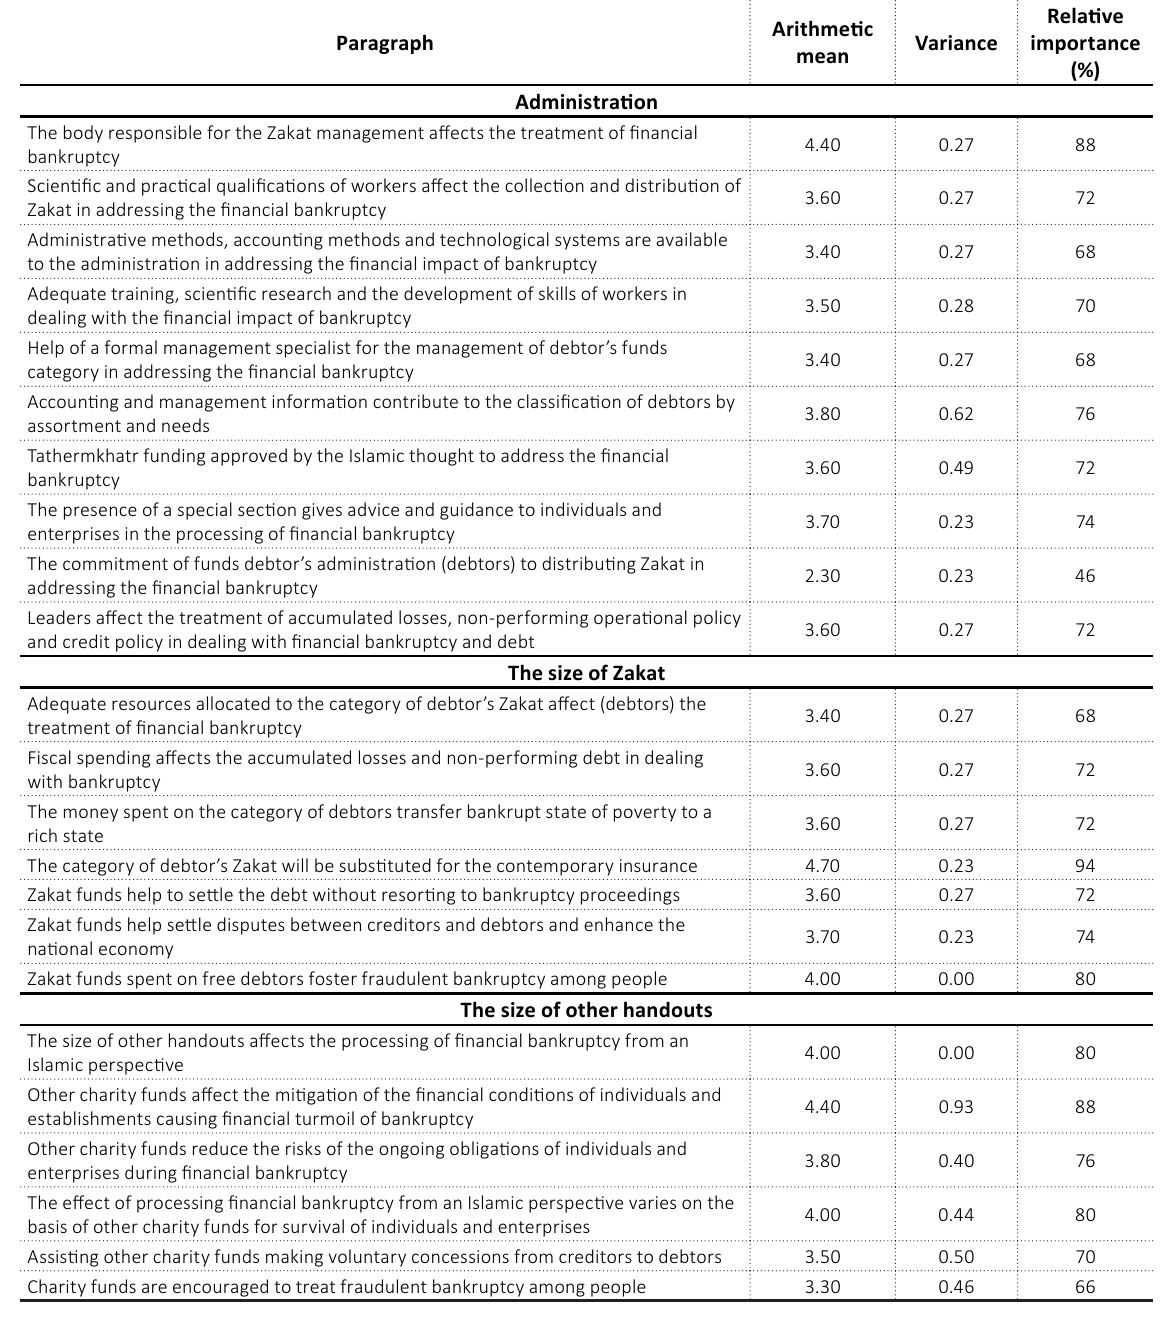
Table 4. Arithmetic average contrast and the relative importance of the independent variables (administration, the size of Zakat, the size of other handouts, creditors, and suppliers)